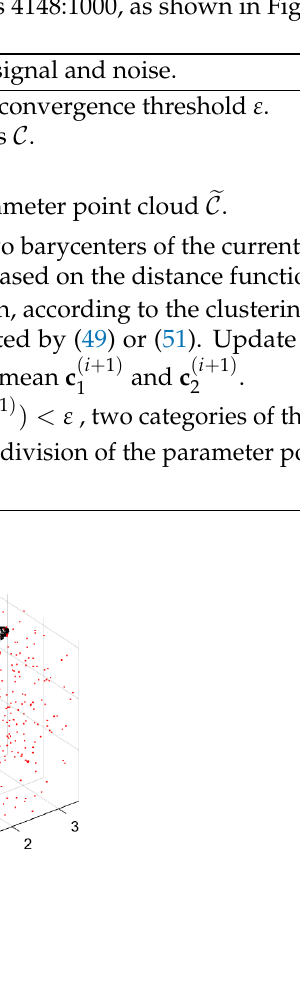
Figure 8. Original data